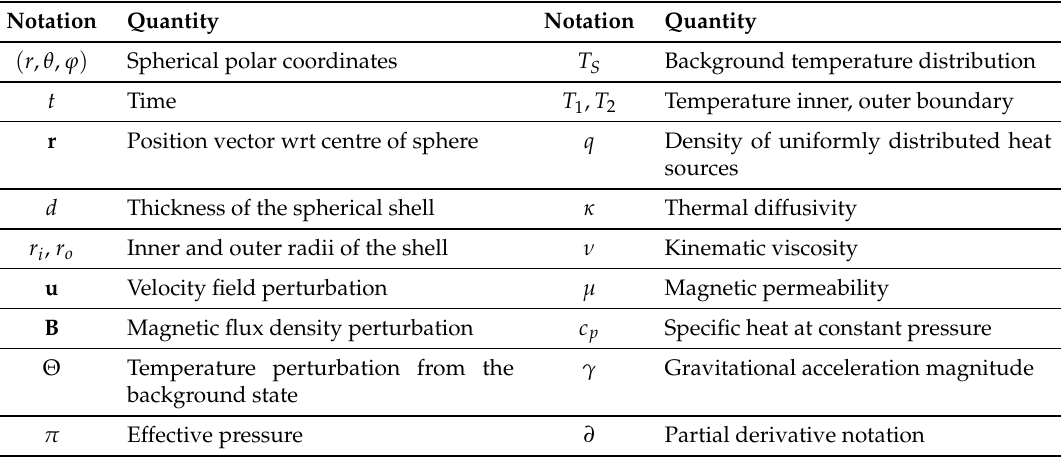
Table 1. Notation used in Section 2.1, where not defined in the main text.